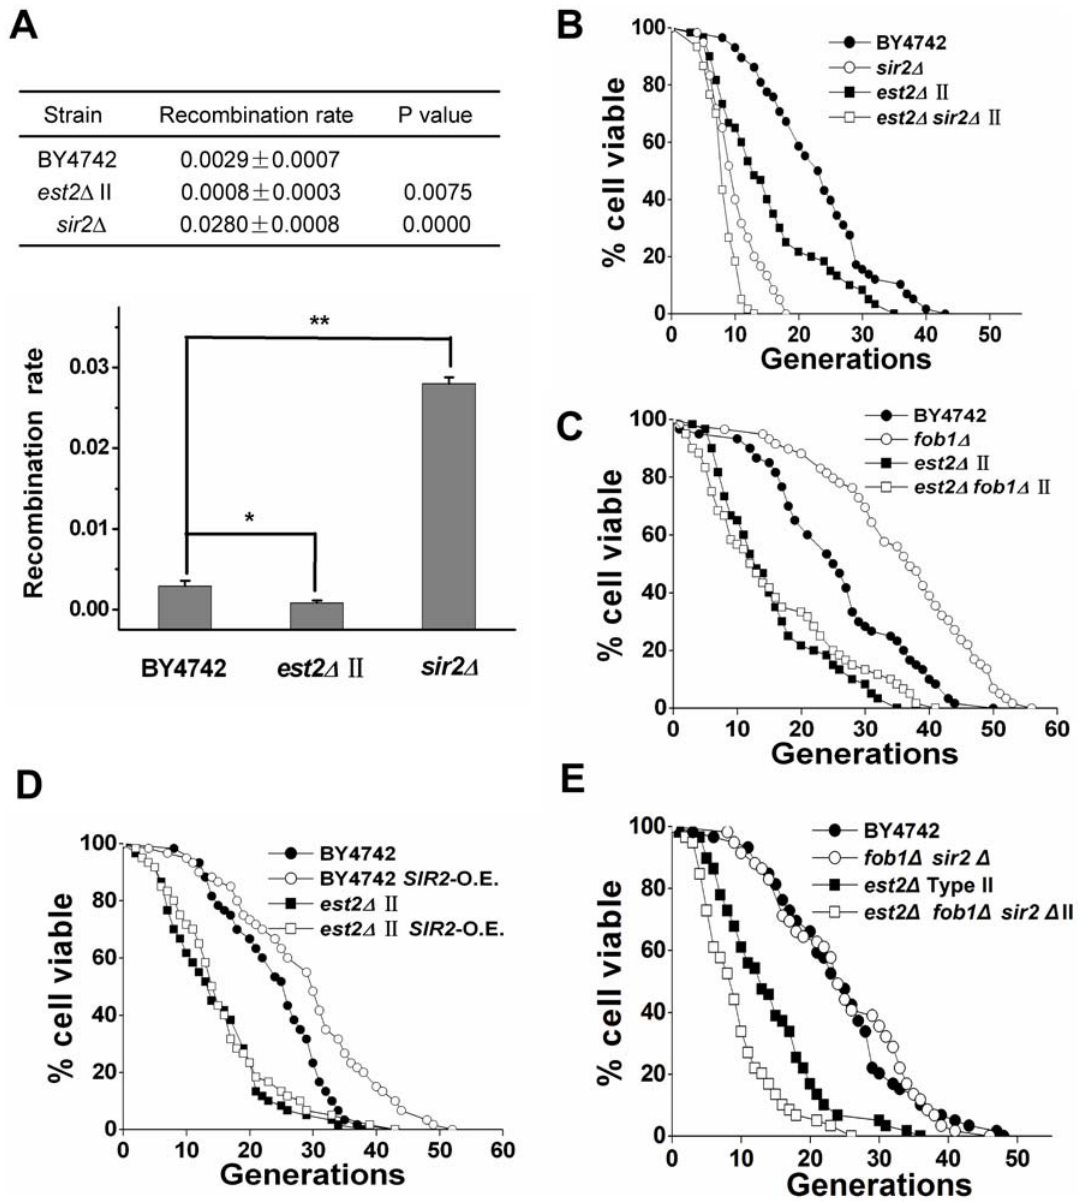
Figure 7. rDNA recombination is reduced in telomerase-null type II survivor cells. (A) rDNA recombination assay. The upper panel shows the average recombination rate of three independent isolates with indicated standard deviations. Approximately 20,000–30,000 colonies were examined for each strain. P values were obtained using student’s t test. The lower panel contains a graph of the average recombination rates and standard deviations from the upper panel. (B) Life span analysis of est2 D type II survivors with SIR2 deletion. Mean life span of strains shown: BY4742, 23.1 6 8.6 (n=58); sir2 D , 10.3 6 3.7 (n=60); est2 D type II, 14.6 6 8.6 (n=59); sir2 D est2 D type II, 8.55 6 4.42 (n=53). (C) Life span analysis of est2 D type II survivors with FOB1 deletion. Mean life span of strains shown: BY4742, 25.5 6 10.9 (n=60); fob1 D , 35.7 6 12.0 (n=59); est2 D type II, 14.6 6 8.5 (n=59); fob1 D est2 D type II, 13.4 6 10.7 (n=59). (D) Life span analysis of est2 D type II survivors with SIR2 over-expression. Mean life span of strains shown: BY4742, 23.8 6 7.6 (n=60); BY4742 SIR2 -O.E., 29.0 6 11.2 (n=60); est2 D type II, 14.7 6 8.0 (n=60); est2 D type II SIR2 -O.E., 15.9 6 8.9 (n=60). (E) Life